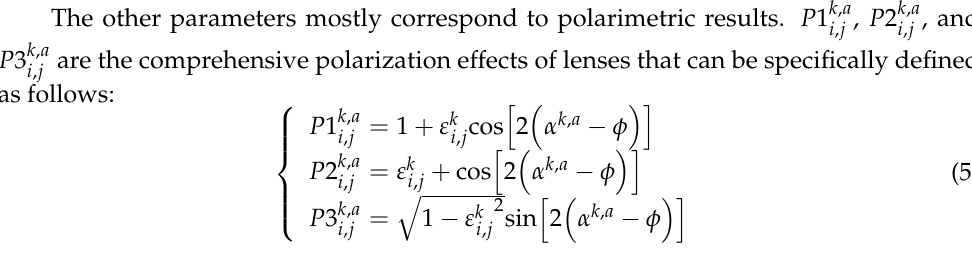
Figure 2. The layout diagram of the POSP onboard calibrators.